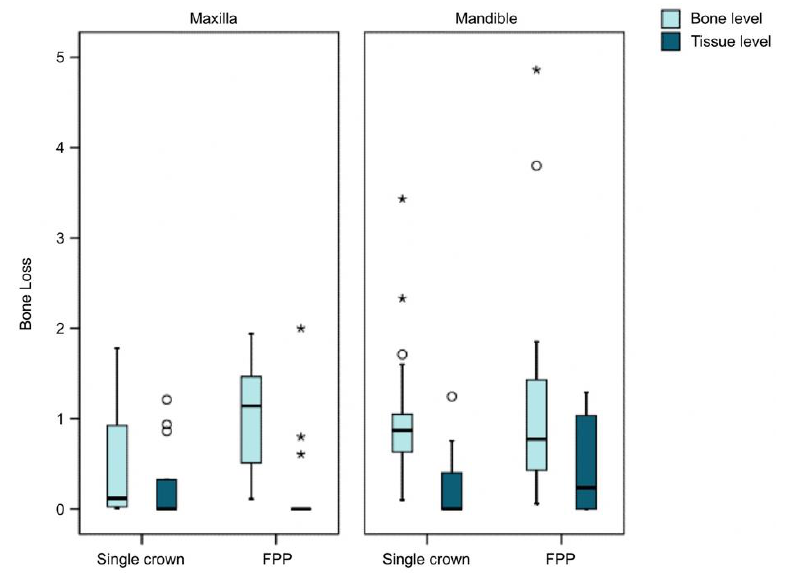
Figure 12. bone loss according to type of prosthesis and implant. * major outlier ° minor outlier. Figure 12. Bone loss according to type of prosthesis and implant. * major outlier ◦ minor